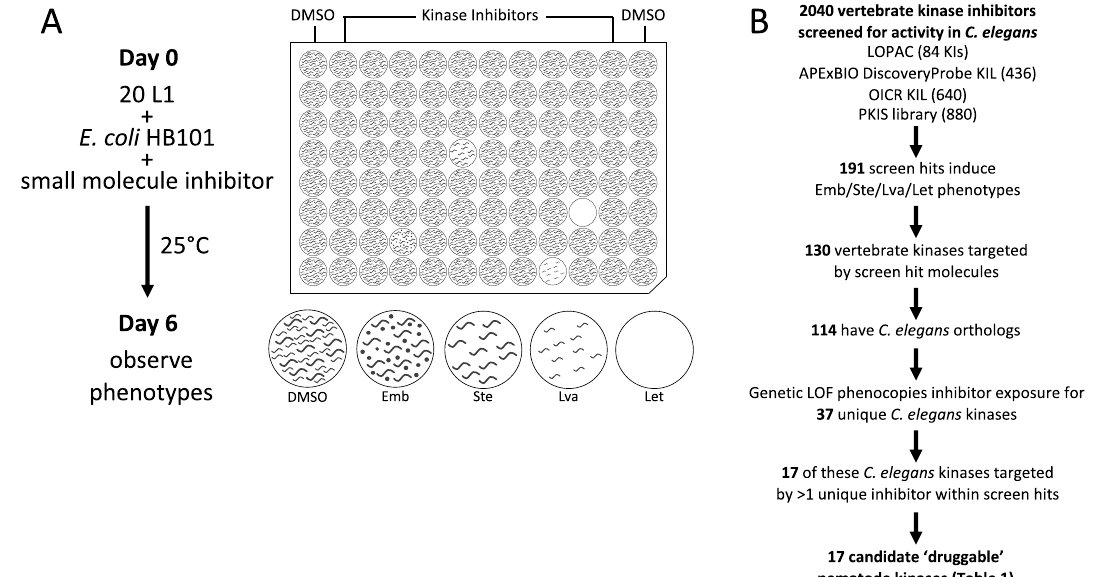
Figure 1. A screen of vertebrate kinase inhibitors reveals 17 druggable nematode kinases. ( A ) Schematic of small molecule screening methodology. ( B ) The pipeline used to identify candidate nematode kinase targets for structure